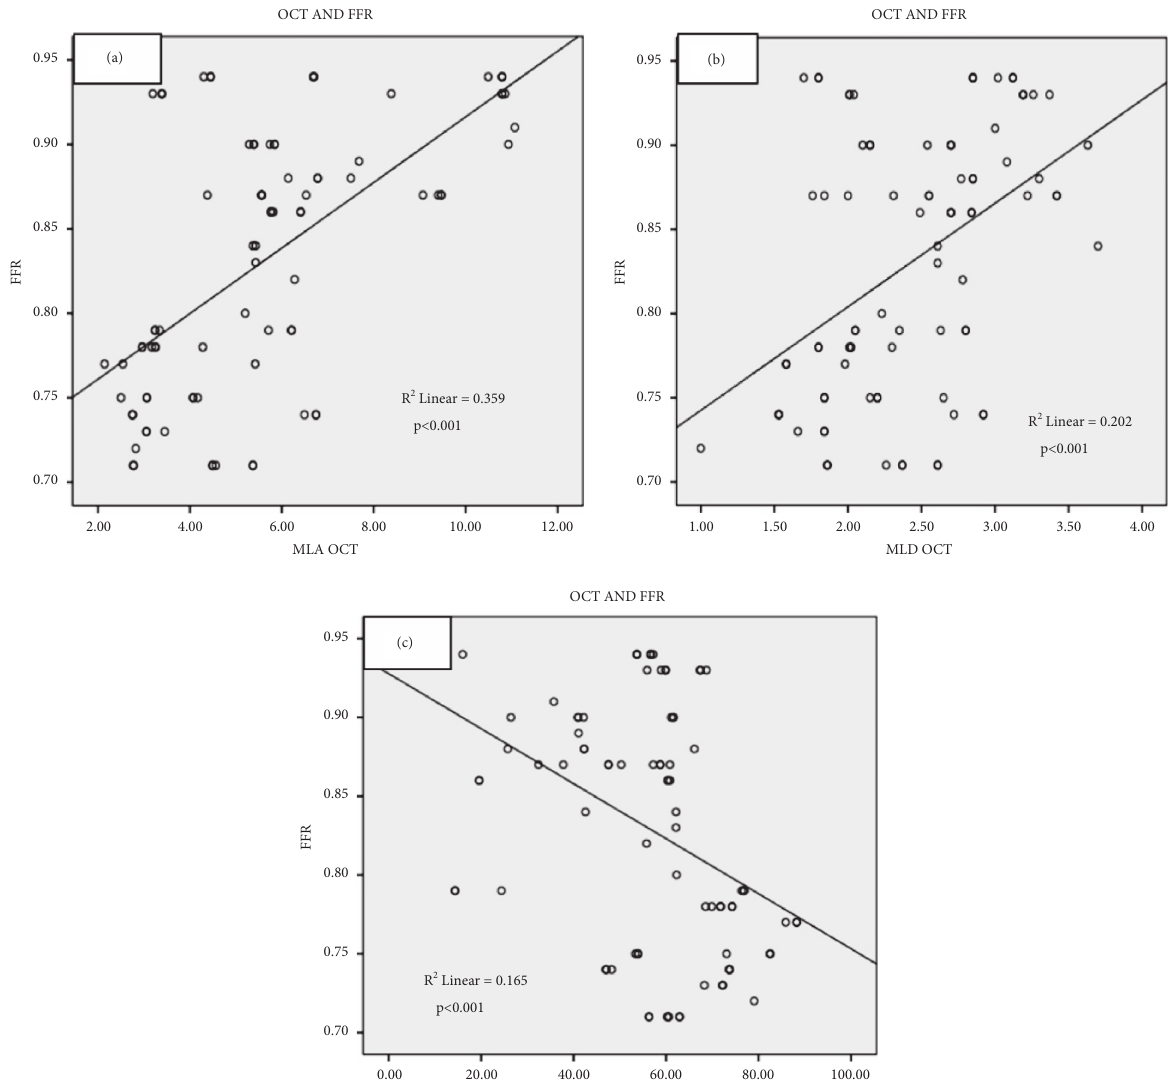
Figure 2: Relation between optical coherence tomography (OCT) measurements and fractional flow reserve (FFR). (a) Relation between minimum lumen area (MLA) and FFR, (b) relation between minimum lumen diameter (MLD) and FFR, and (c) relation between percent area stenosis (% AS) and